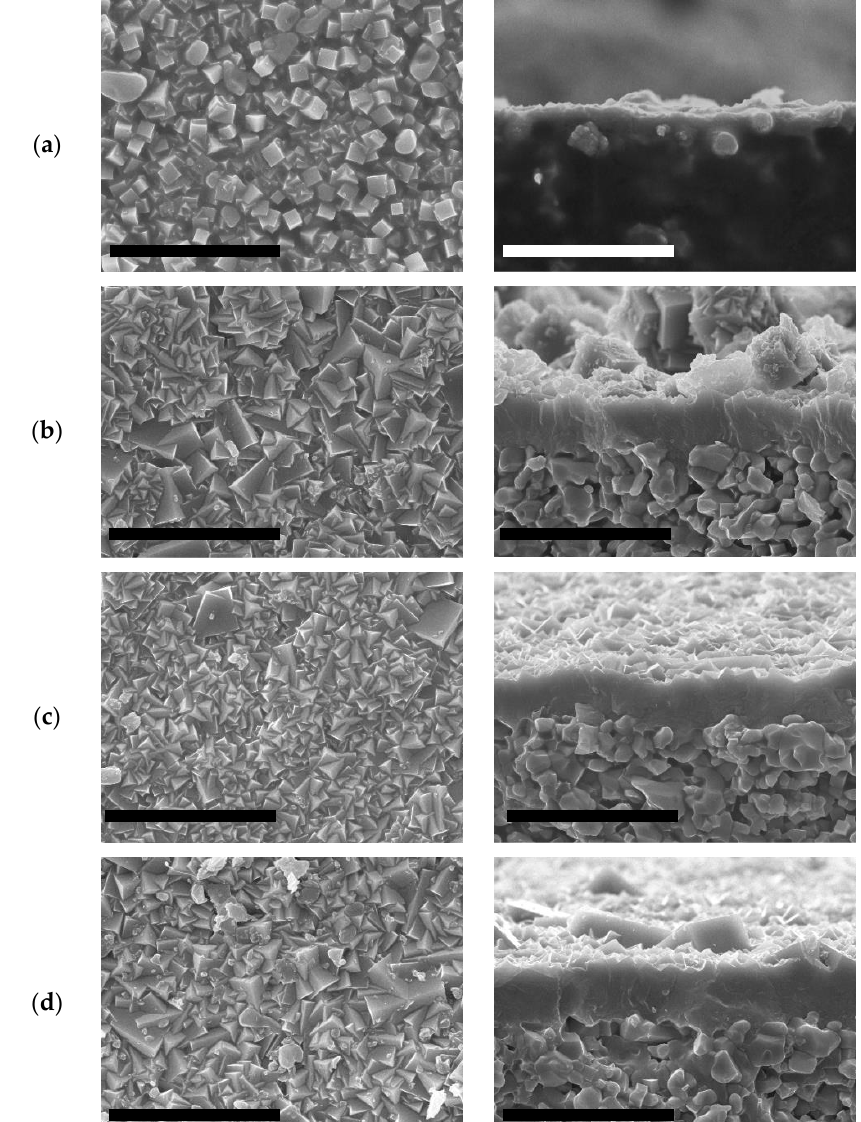
Figure 6. SEM images of top (left) and side (right) views of ITQ-29 materials grown on the alumina supports prepared at different crystallization times: ( a ) 3 days; ( b ) 7 days; ( c ) 10 days; ( d ) 14 days. Scale bars correspond to 30 µm.